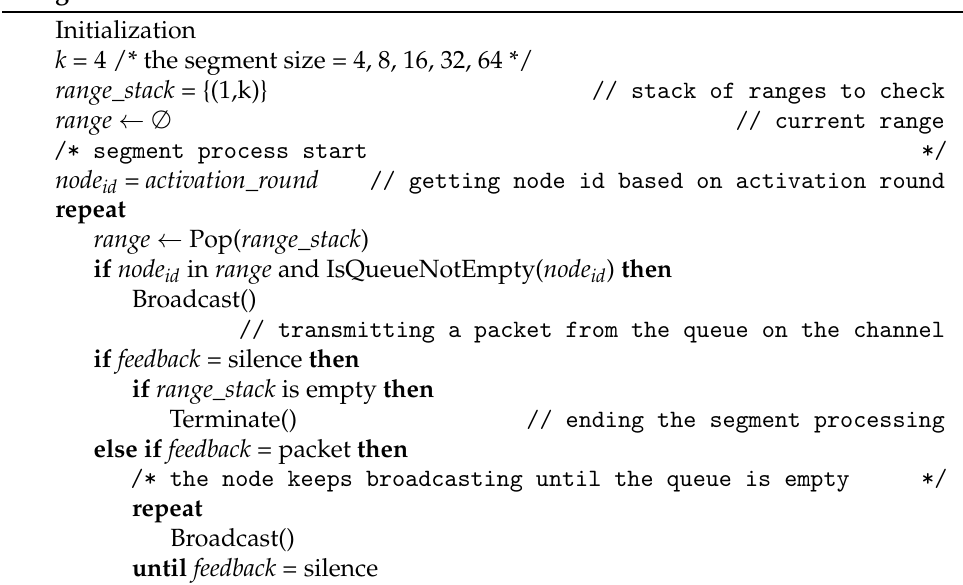
Algorithm 1: K- TUPLE FULL WITHHOLDING